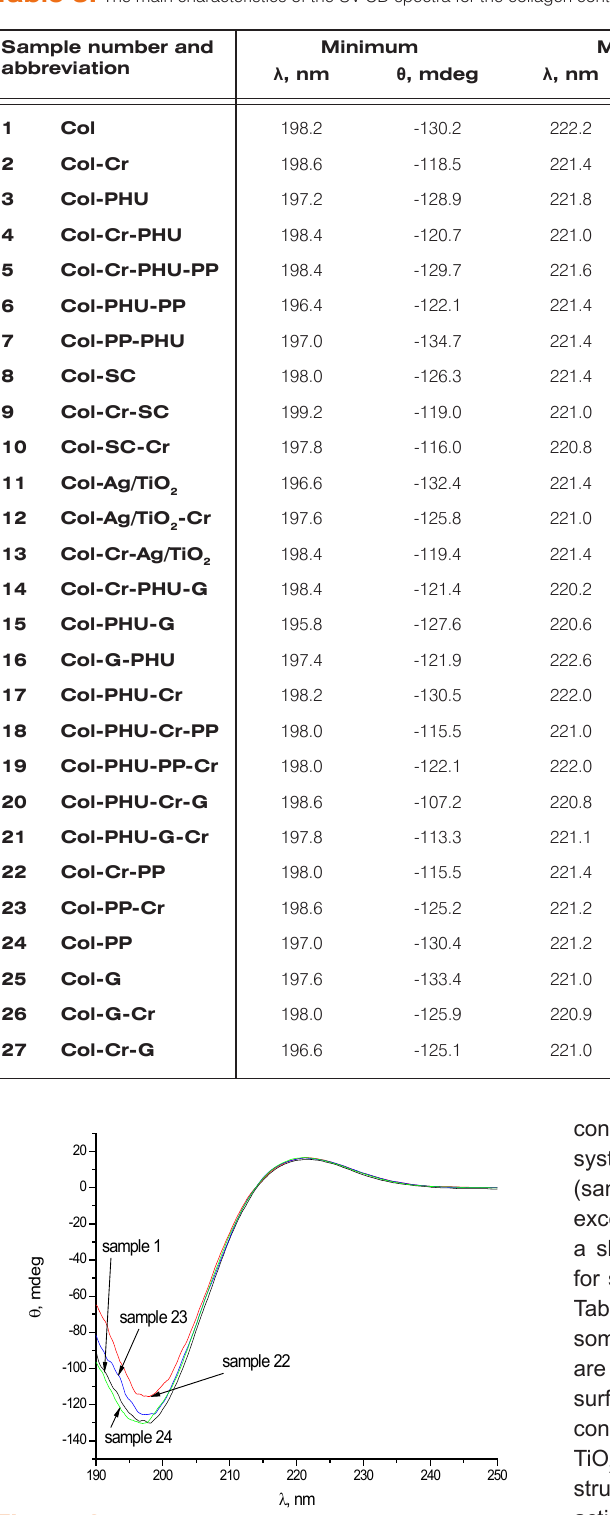
Table 3. The main characteristics of the UV-CD spectra for the collagen contained within the investigated mixtures.